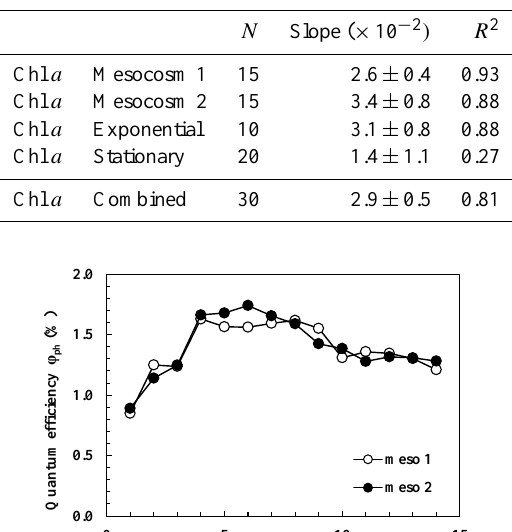
Table 4. Linear regression equations of Phaeocystis fluorescence on HPLC-measured chlorophyll a concentrations. Fluorescence was calculated with the FLH-H algorithm (Eq. 2). Regressions were made for the mesocosms separately, for exponential (day 0–4) and stationary (day 5–14) growth phases. Indicated are slopes and inter- cepts ± 95% confidence intervals.